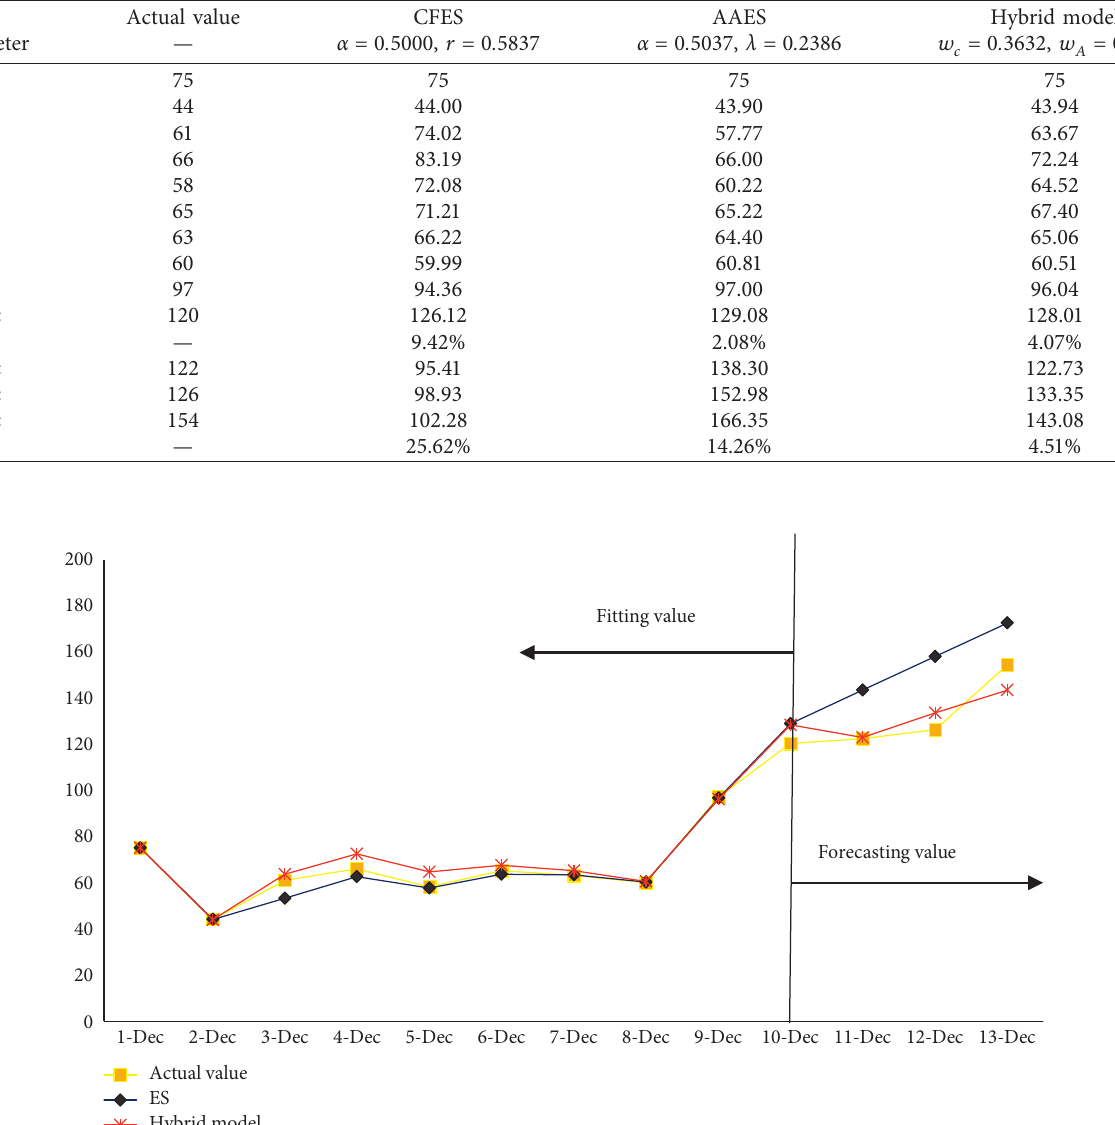
10 concentration.